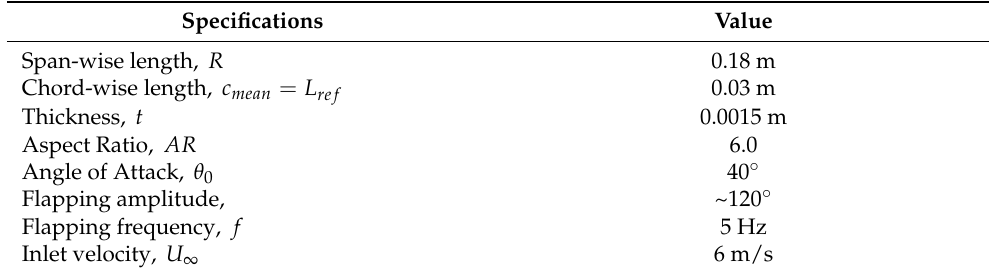
Table 2. Wing specifications for turbulence model validation reference to Lee et al.